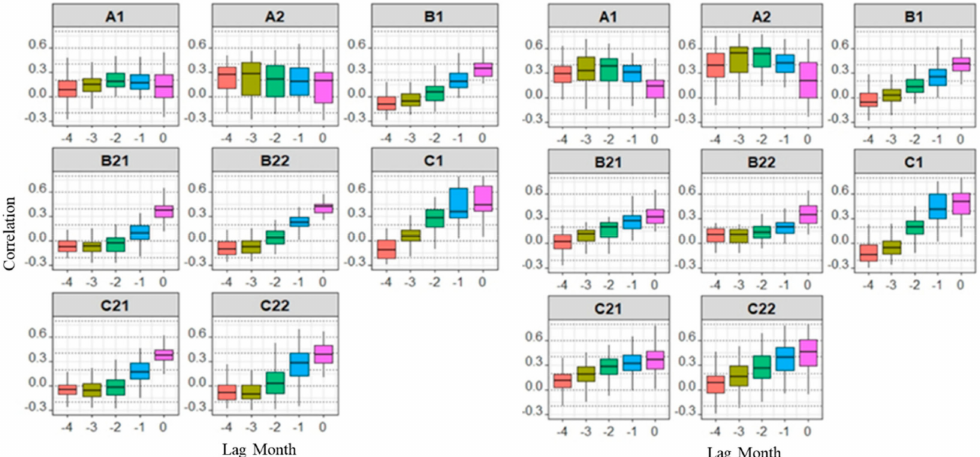
Figure 6. Box plots of lag correlations between precipitation and streamflow ( left ) and SMOS- based root zone soil moisture and streamflow ( right ) for eight watershed classes. The lower and upper ends of the box represent the first and third quartiles, respectively, and the whiskers extend to the extreme value within 1.5 IQR (interquartile range) from the box